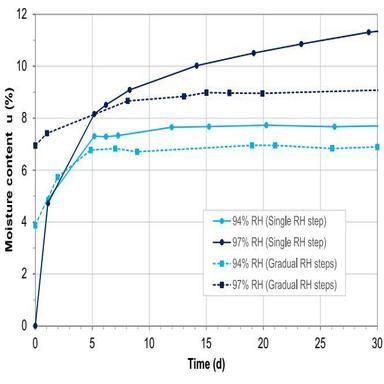
Typical initial sorption kinetics at RH= 94% and RH= 97%.